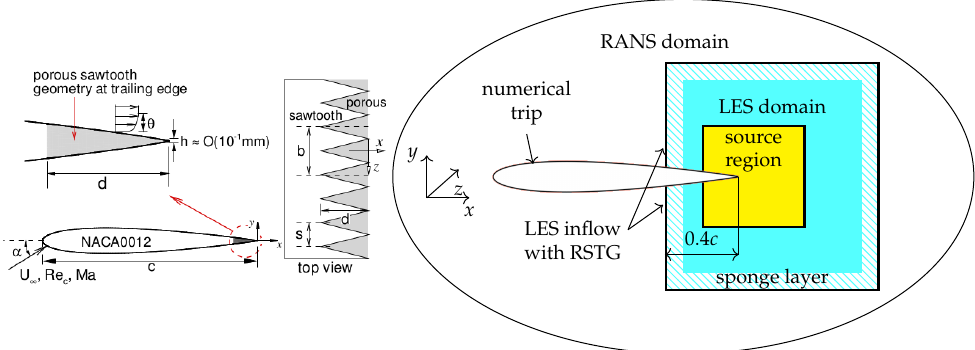
Figure 1. Schematic of the poro-serrated TE with b = d = 0.15c ( left ) and schematic of the RANS and the LES domains around the NACA 0012 aerofoil including the acoustic source region ( right